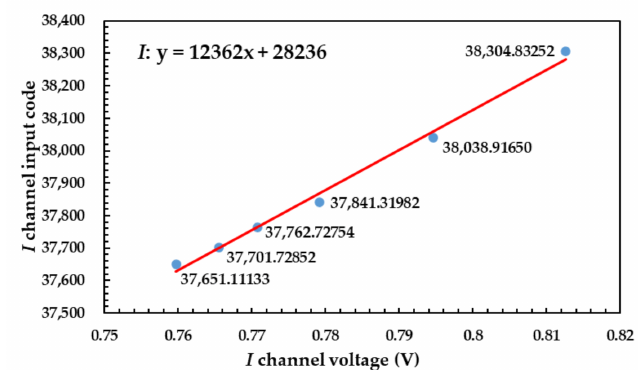
Figure 19. Corrected result of I channel using correction algorithm. The corrected result of Q channel is shown in Figure 20.